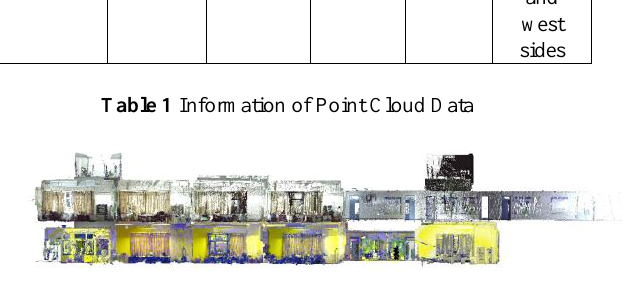
Figure 5 . Field Data Collection on the First and Second Floors of Building F,